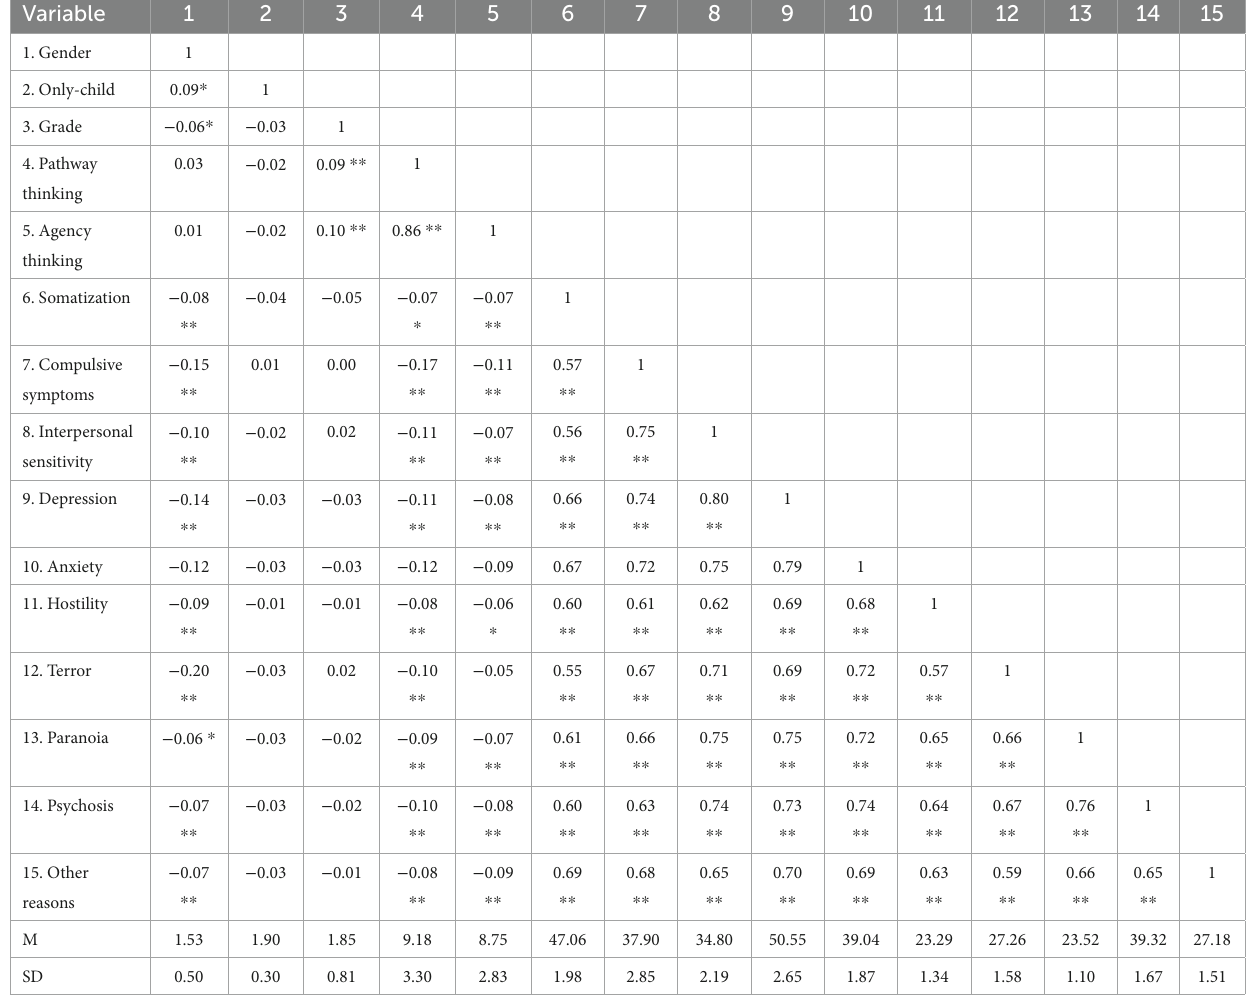
TABLE 1 Summary of means, standard deviations and correlation coefficients for each variable. Variable